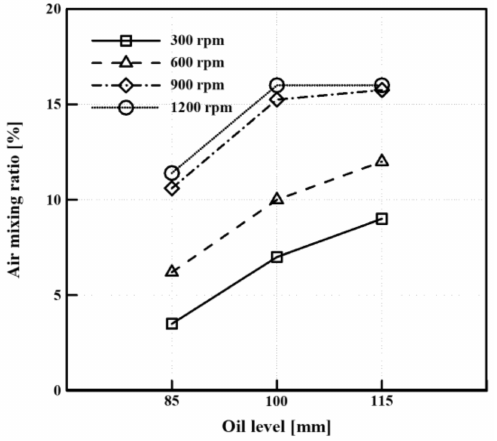
Figure 12. Air mixing ratio based on oil level at 60 ◦ C, 0.084